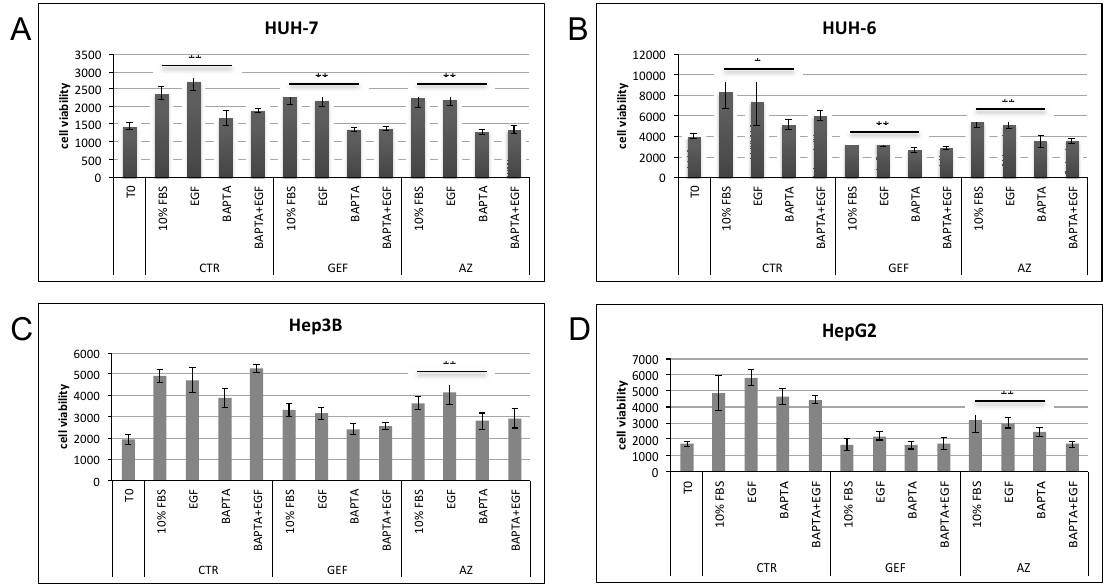
Figure 11. 48 h proliferation assay of ( A ) HUH-7, ( B ) HUH-6, ( C ) Hep3B and ( D ) HepG2 cell lines. After 2 h starvation (in 0% FBS medium) cells were treated or not in 10% FBS medium with BAPTA_AM for 1 h. After 1 h, 0.5 × GEF, AZ or DMSO (as CTR) was added to the medium for 48 h. p value < 0.05 (*); p value < 0.01 (**) .